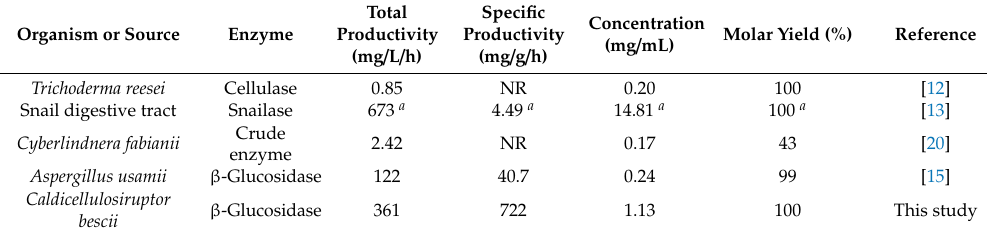
Table 3. Biotransformation of platycosides in the Platycodi radix extract into platycodin D.